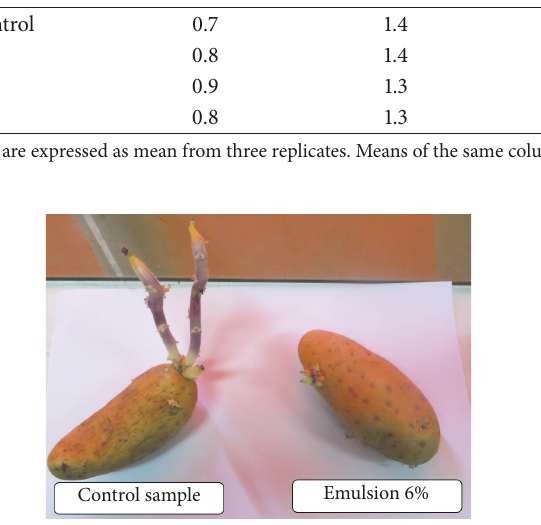
Figure 4: Effect of Ruta chalepensis essential oil on potato weight loss during storage: potatoes during the week 6 of storage: at the right, a potato treated with emulsion 6%; at the left, control sample potato.